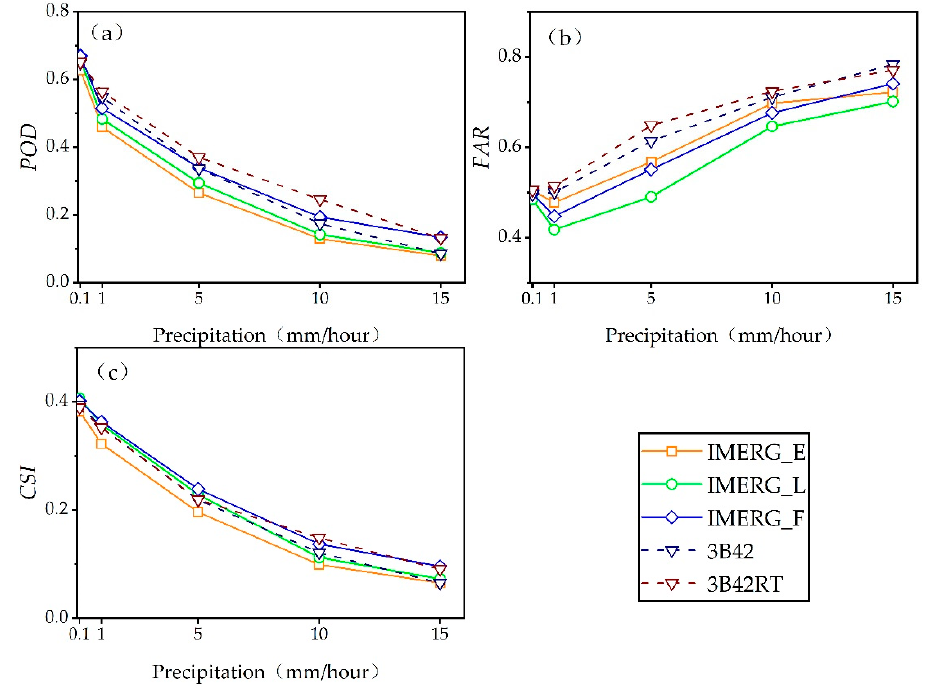
Figure 11. Comparison of the changes in categorical evaluation metrics (April to October) with hourly rainfall thresholds among five SPPs: ( a ) POD ; ( b ) FAR ; and ( c ) CSI .